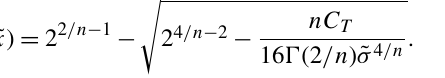
in the far wake. For n = 2, the super-Gaussian is actually a Gaussian